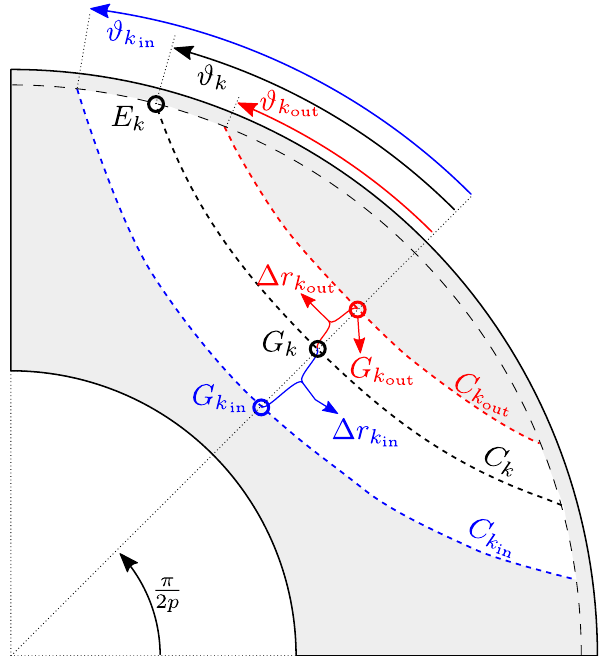
Figure 3. Construction of single barrier.